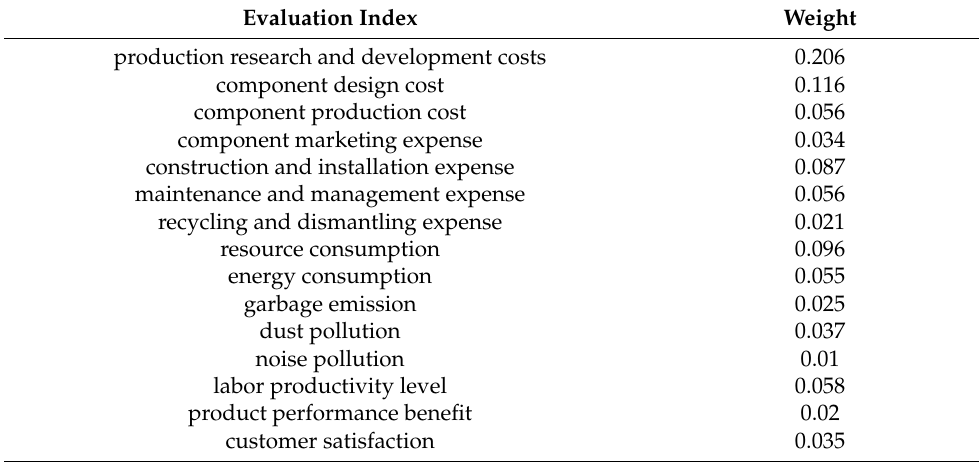
Table 8. Reference model indicators and weights.